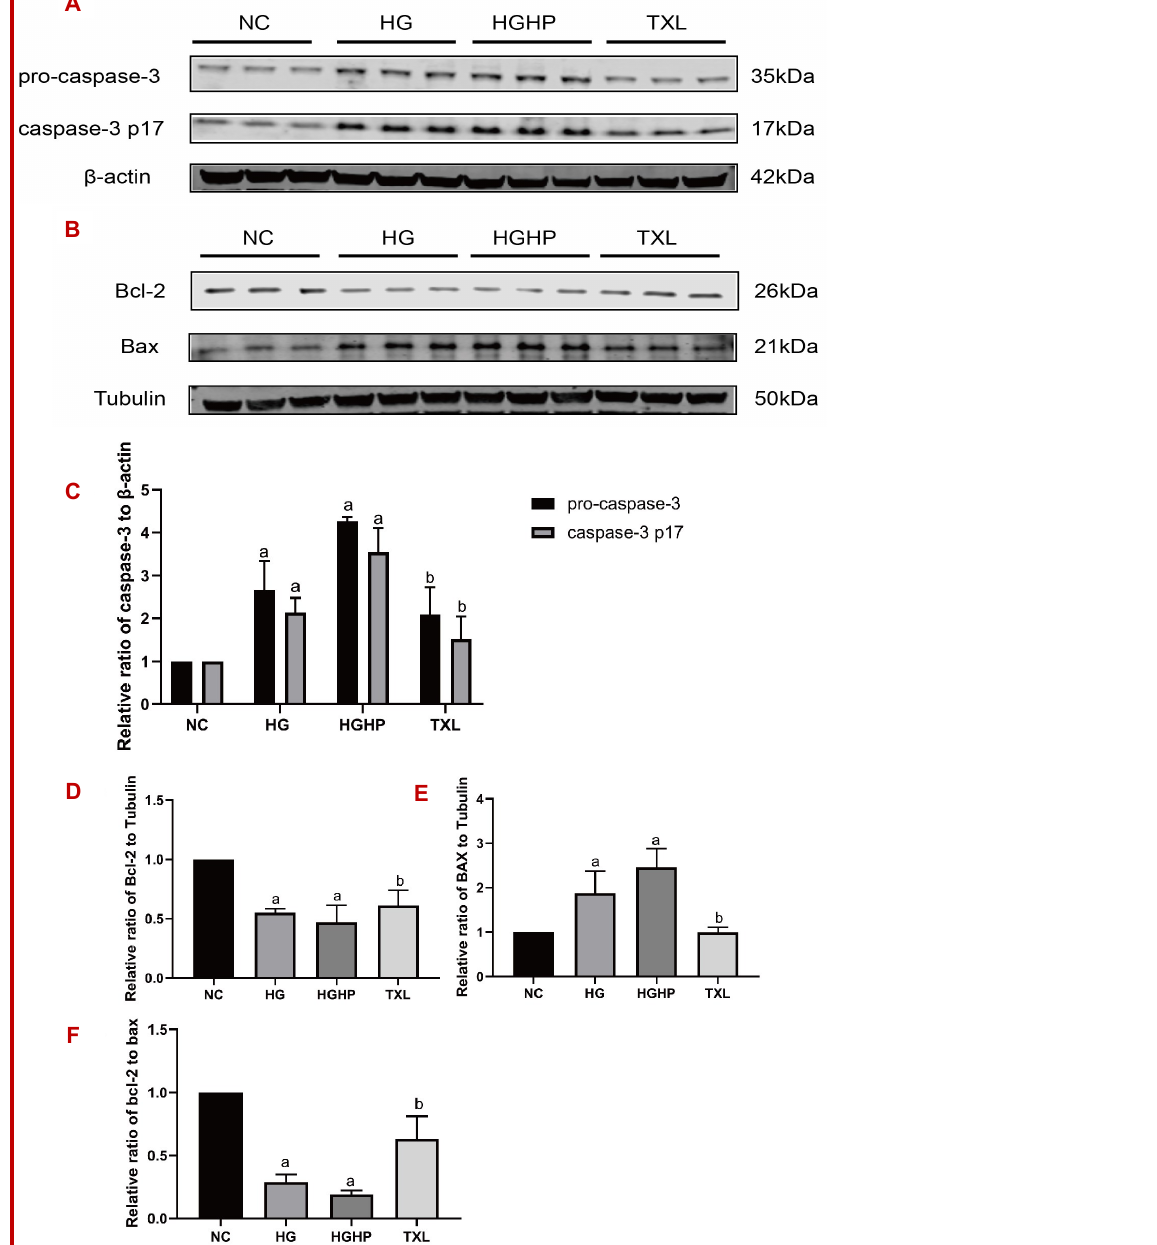
Figure 6: Effect of Tongxinluo (TXL) on apoptosis in the HK-2 cells exposed to high-glucose (HG) and high-glucose combined with high-palmitic acid (HGHP). Representative band of caspase-3, Bcl-2 and Bax by Western blot in vitro (n=3 per group) (A, B); Semiquantitative analysis of average optical density of caspase-3, Bcl-2 and Bax (C~E); Relative ratio of Bcl-2 to Bax (F). The values represent means ± SEM. a p<0.05: the significant difference with respect to normal control (NC) group; b p<0.05: the significant difference with respect to HGHP